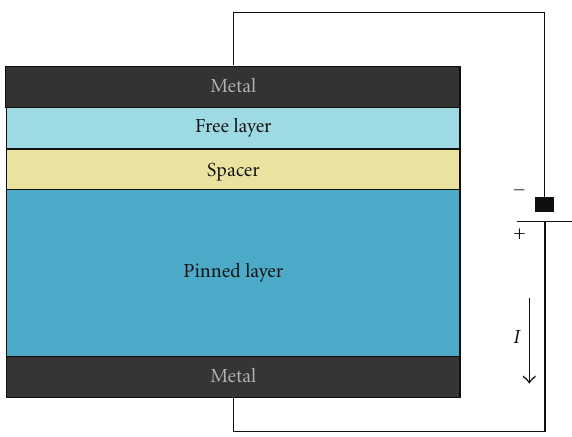
Figure 2: A schematic of a spin-valve nanopillar